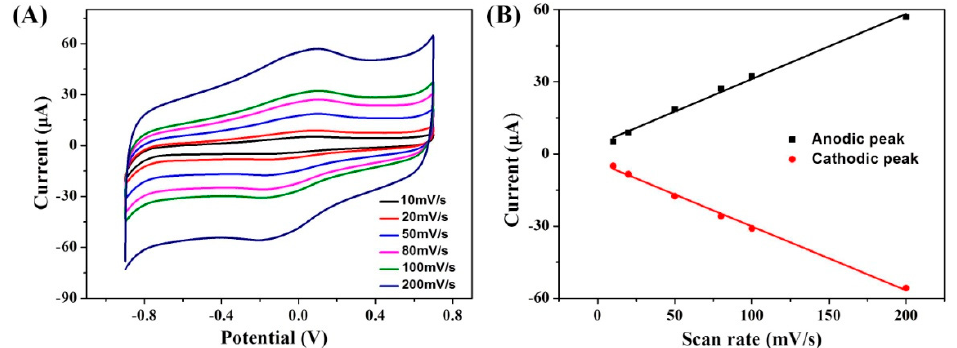
Figure 4. ( A ) CV curves of GCE/ERGO-Nafion/AuNPs/Cyt c /Nafion electrodes in 0.2 M PBS (pH = 7.0) at varied scan rates from 10 mV/s to 200 mV/s. ( B ) Plots of redox peak current of GCE/ERGO-Nafion/AuNPs/Cyt c /Nafion electrode vs scan rates. The correlation coefficient (R 2 ) is 0.9975 and 0.99.85 for the oxidation and reduction peak current, respectively.